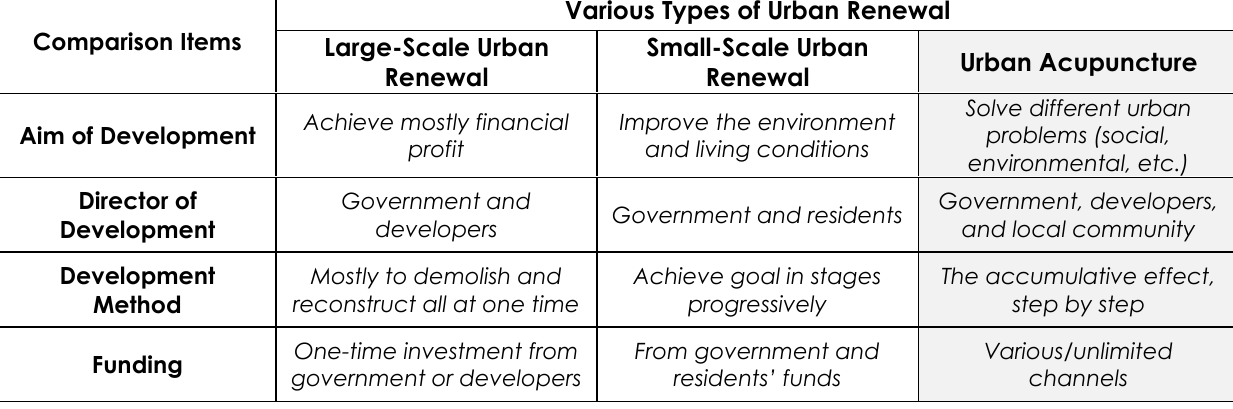
Table 1. Comparison between UA, Large and Small-Scale Urban